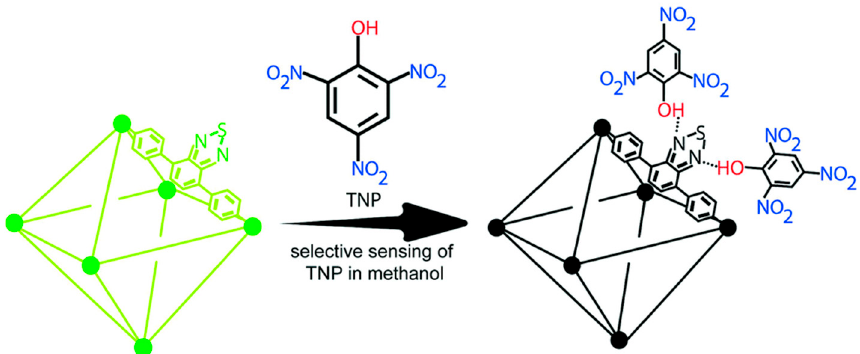
Figure 4. Schematic representation for the selective detection of TNP by a Zr-MOF constructed from H 2 BTDB linker. Reprinted with permission from [77]. Copyright (2016) Royal Society of Chemistry.